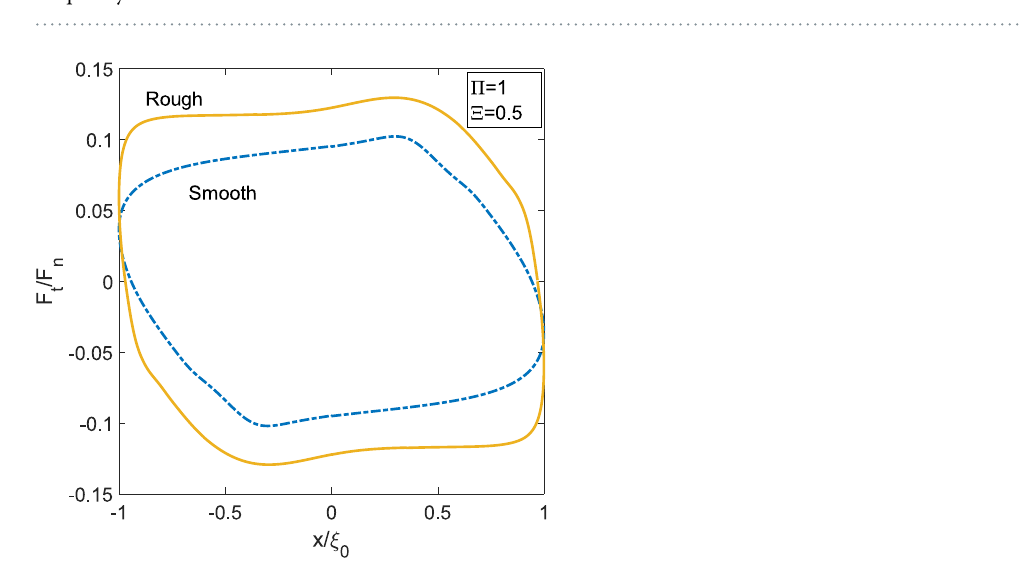
Figure 7. The dimensionless dissipated work δ as a function of the speed Π and for several values of the frequency Ξ .